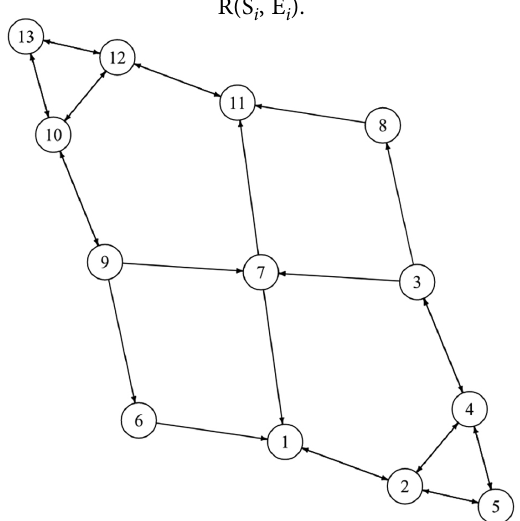
Figure 3. The transitional graph of the trend model M (4) (source: Vicha & Dohnal,